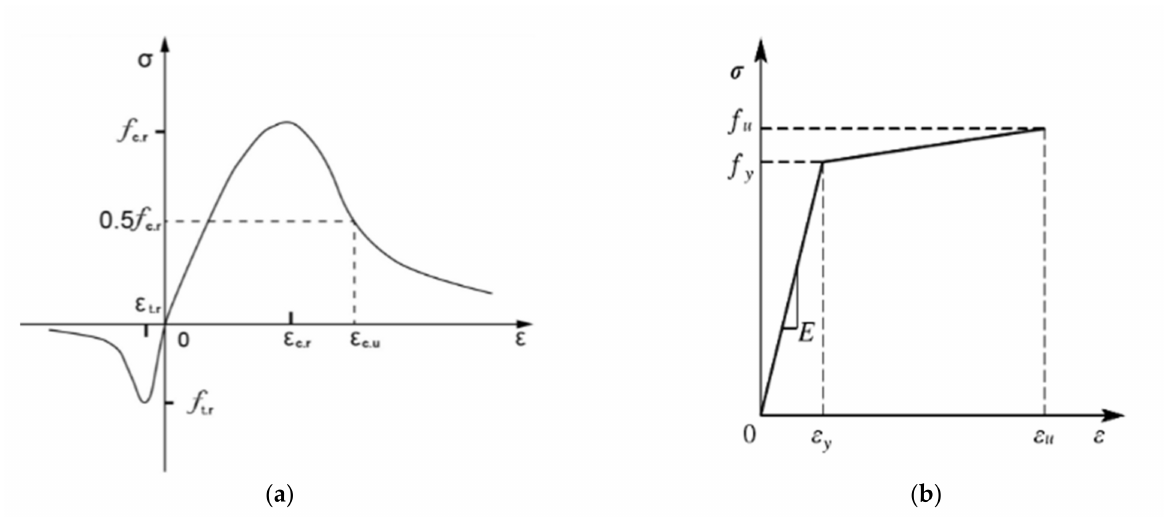
Figure 16. Stress and strain curves: ( a ) stress and strain of concrete; ( b ) stress and strain of steel.